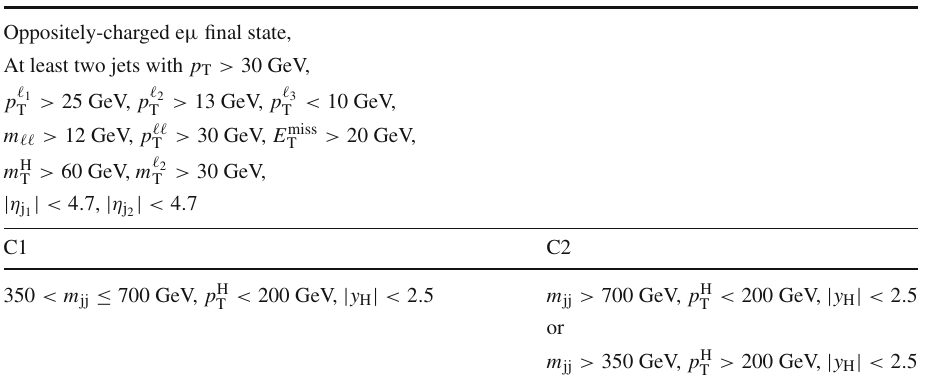
Global selection Oppositely-charged e μ final